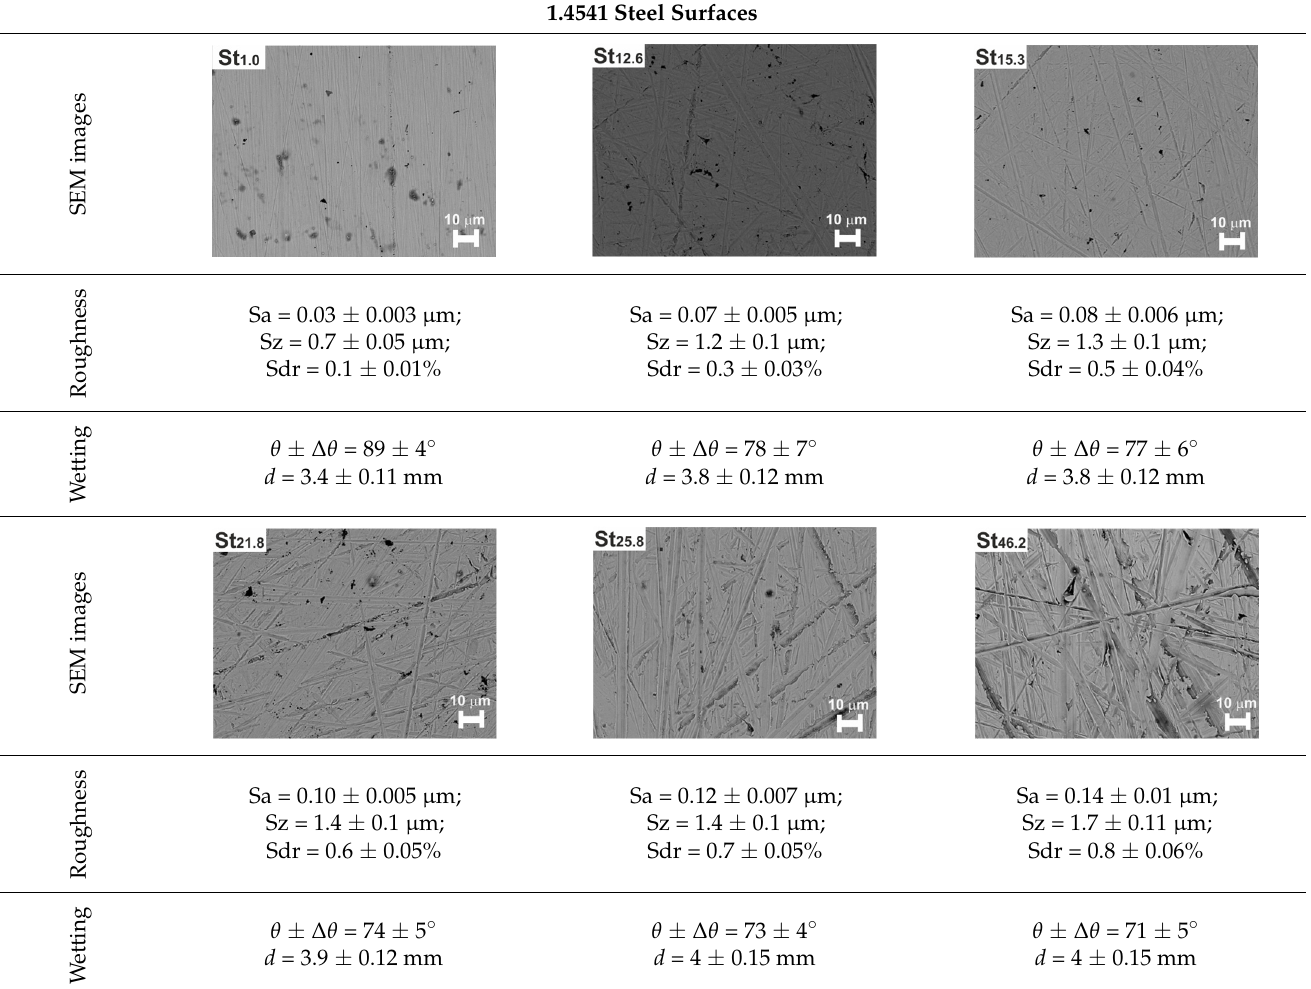
Table 2. SEM images and parameters characterizing roughness and wetting of steel surfaces.